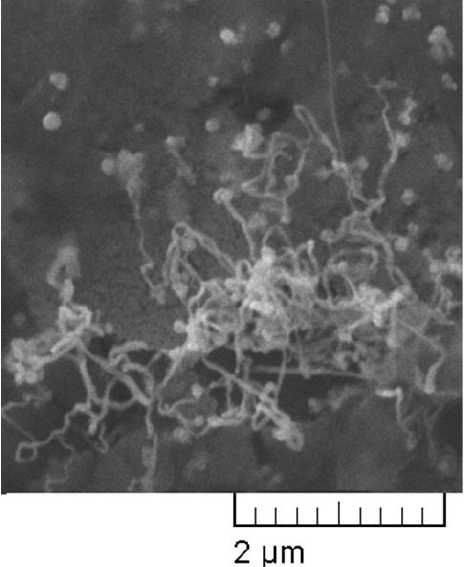
Figure 3. SEM image of fibers with nanosized diameter and silver particles (2%).